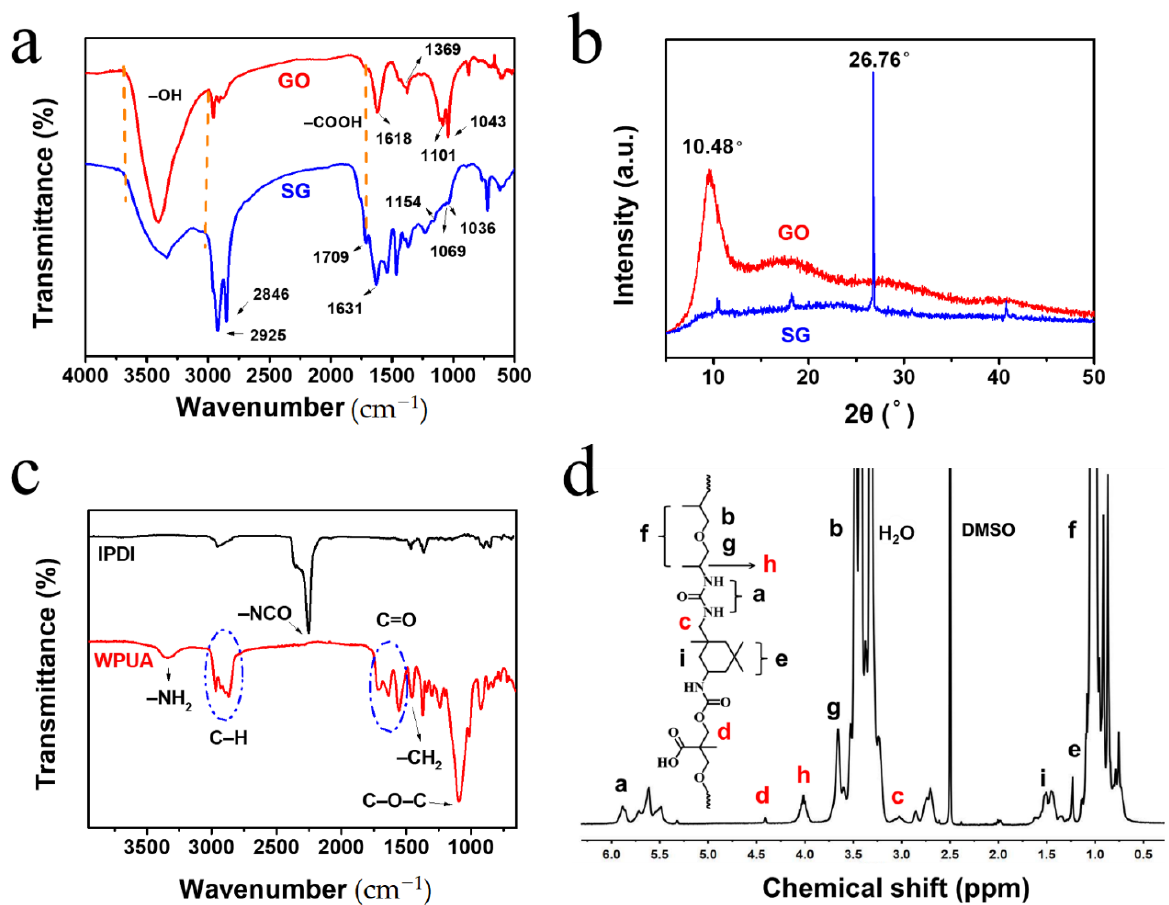
Figure 3. FT-IR spectra ( a ) and X-ray diffraction spectra ( b ) of GO and SG, FT-IR spectra ( c ), and 1 H NMR spectrum ( d ) of WPUA.